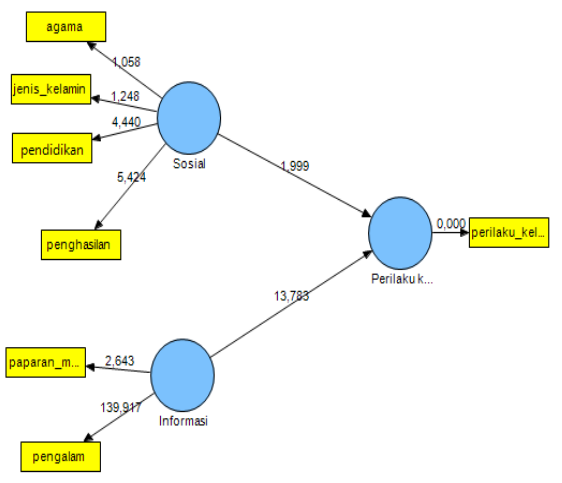
Figure 1. Value of loading factor and t-statistics value of the